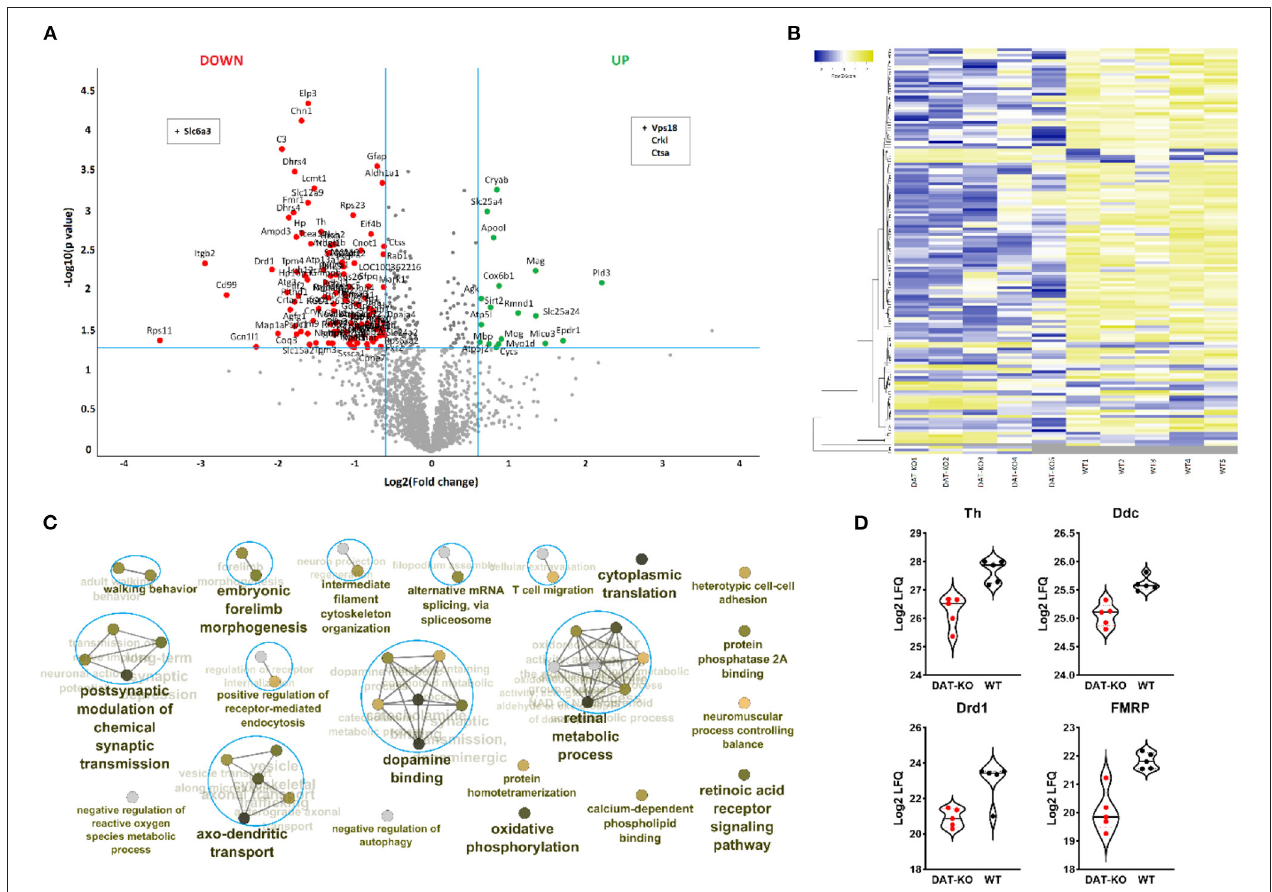
FIGURE 4 | Enriched synaptosomal striatal fractions from DAT-KO rats and WT were subjected to label-free quantitative proteomic analysis. (A) A volcano plot showing proteins upregulated (green) and downregulated (red) in the DAT-KO group compared to WT ( p < 0.05, fold-change > 1.5). The protein groups in the upper middle section (black) are those which fulfilled the requirement for the p -value cut-off ( p < 0.05) but did not match the fold-change cutoff. (B) A hierarchical clustering heatmap is presented for the differentially expressed proteins ( p < 0.05, fold change > 1.5; n = 5). (C) The clustered network map of enriched gene ontology (GO) Biological Processes and Molecular Function terms on the list of significantly altered proteins between the groups. Enriched GO terms consisting of various related genes are depicted as nodes. The FDR q-value of each GO-term is color-coded. Displayed GO terms are the most significant cases from significantly enriched clusters. The connectivity (edges) between the terms in a functionally grouped network is derived from kappa score, which indicates the similarity of associated genes shared by different terms. (D) The violin plots show protein expression levels of representative differently expresses